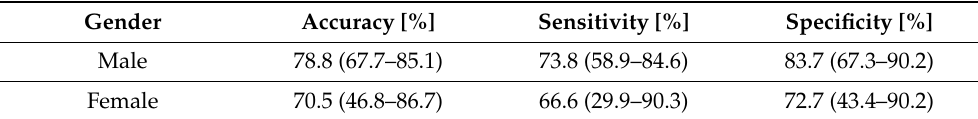
Table 9. Diagnostic performance and 95% CI of the model as a function of patient sex. Gender